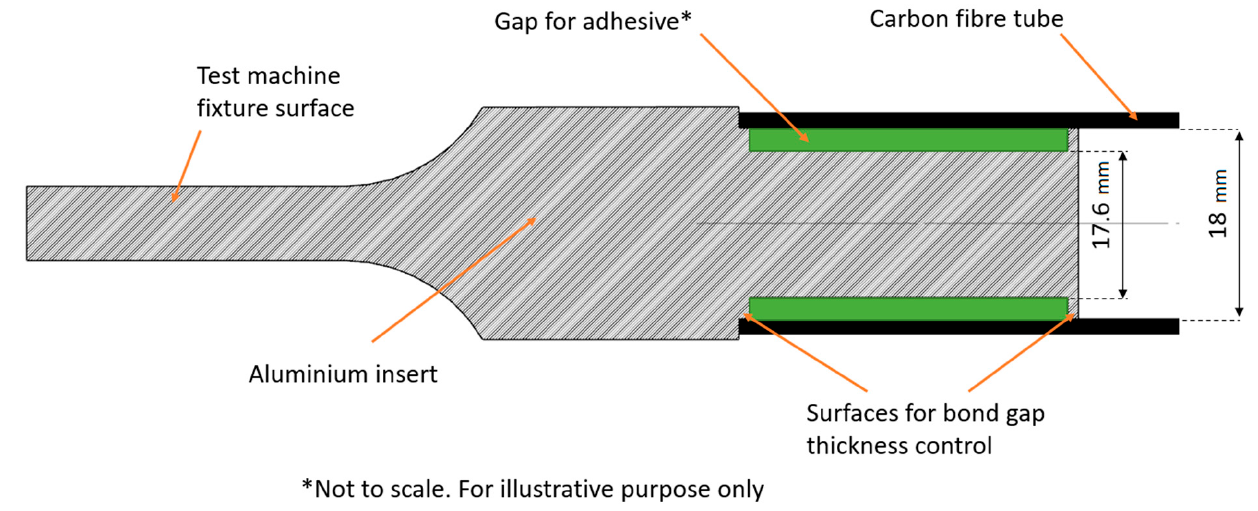
Figure 1. Idea of geometrical solution of bond gap thickness control.